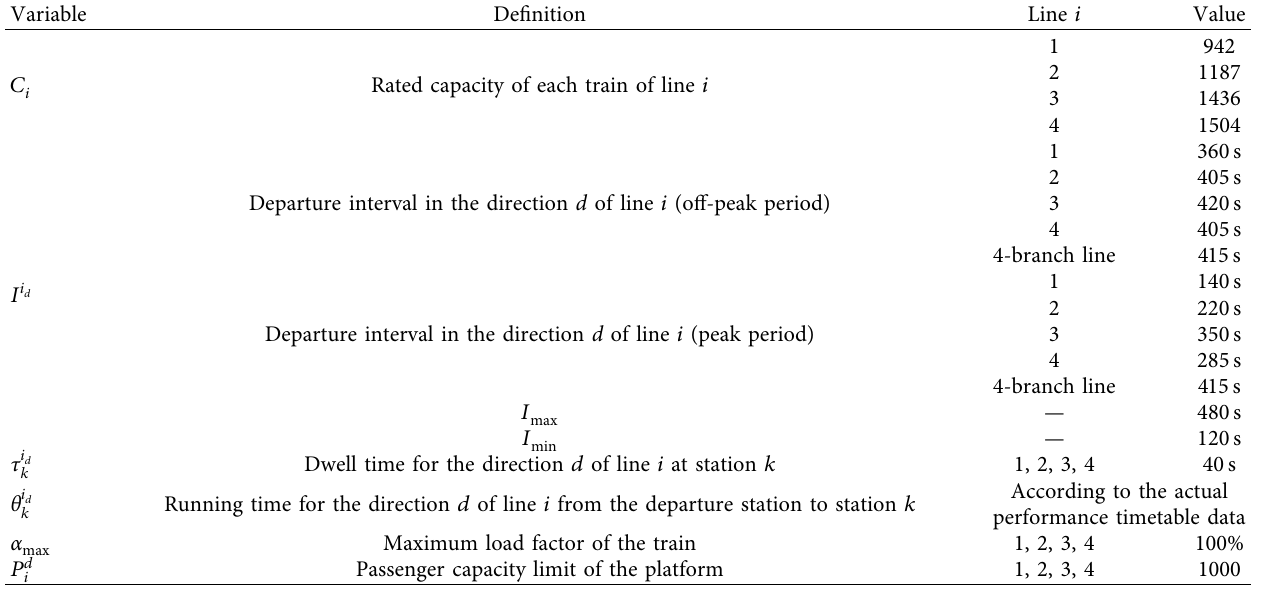
Table 4: Setting model parameters.